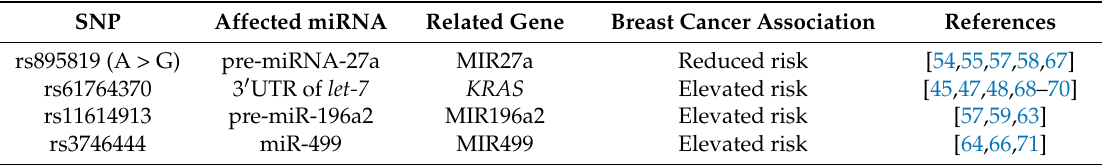
Table 3. miR-SNPs Associated with Breast Cancer Risk